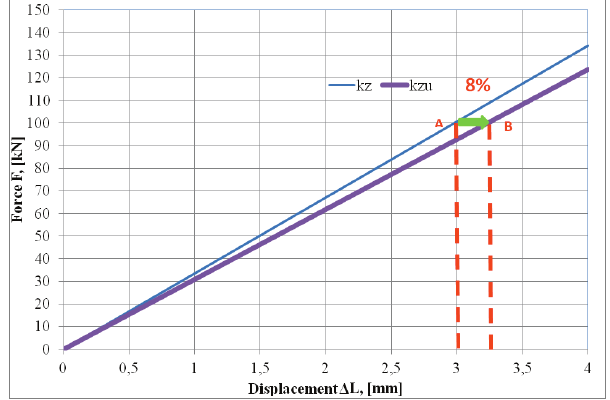
Fig. 35. Detailed loading characteristics for the components of the rock bolt support No. 5A